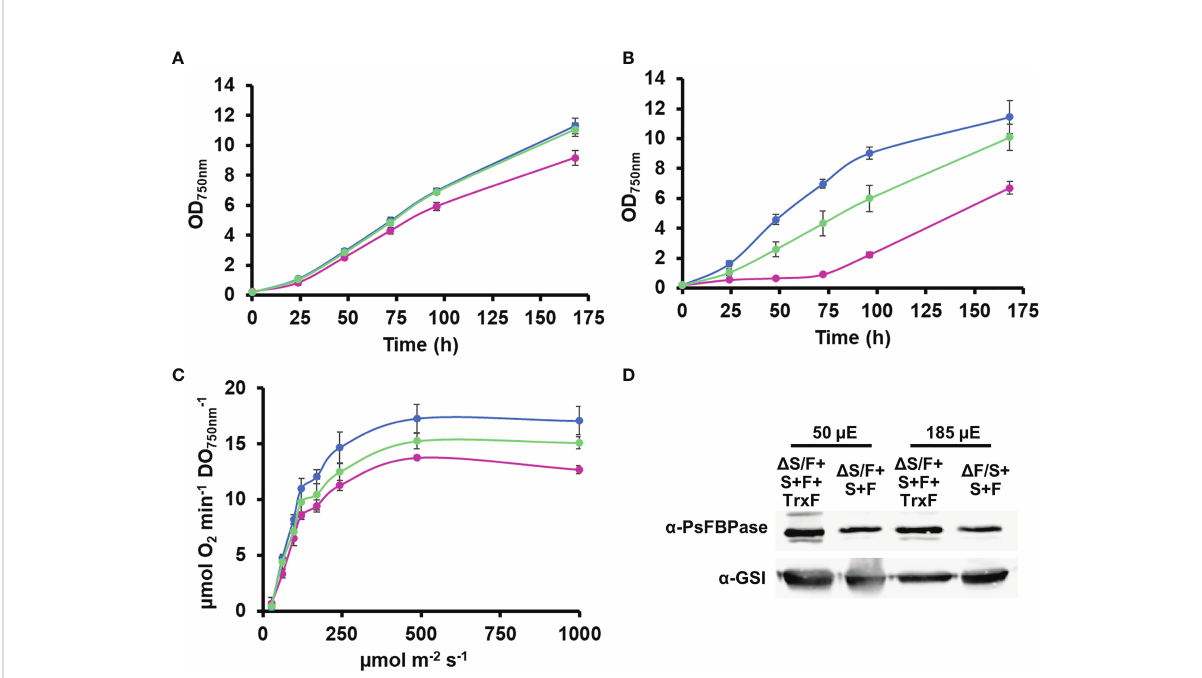
FIGURE 5 Expression of TrxF improves D S/F D F+S+F growth. (A) Photoautotrophic growth of WT and D S/F+S+F in liquid media. WT ( ○ ), D S/F+S+F ( ○ ), and D S/F+S+F+TrxF ( ○ ) were grown in BG11C in low light until the exponential phase. Cells were inoculated in BG11C glucose at OD bubbled with 1% CO 2 -enriched air at 50 µmol photon m − 2 s − 1 . Data represented are the mean and standard error of three to four (depending on the time point) biological independent cultures. (B) Photoautotrophic growth of WT and D S/F+S+F in liquid media. WT ( ○ ), D S/F+S+F ( ○ ), and D S/F+S+F+TrxF ( ○ ) were grown in BG11C in low light until the exponential phase. Cells were inoculated in BG11C at OD 750nm 0.2 and bubbled with 1% CO 2 -enriched air at 185 µmol photon m − 2 s − 1 . Data represented are the mean and standard error of three to four (depending on the time point) biological independent cultures. (C) Oxygen evolution measured using a Clark electrode at increasing light intensities in exponential growing cultures (OD 750nm = 0.5-1) of WT( ○ ), D S/F+S+F ( ○ ), and D S/F+S+F+TrxF ( ○ ) grown in BG11C bubbled with 1% CO 2 - enriched air at 50 µmol photon m − 2 s − 1 . Data are the mean ± SE of at least three biologically independent experiments. (D) Immunoblot analysis of PsFBPase protein in D S/F+S+F and D S/F+S+F+TrxF strains. Cells were grown in BG11C bubbled with 1% CO 2 -enriched air at 50 or 185 µmol photon m − 2 s − 1 . Ten micrograms of total protein from soluble extracts were separated by 12% SDS-PAGE and subjected to Western blot to detect FBPase and GSI as loading